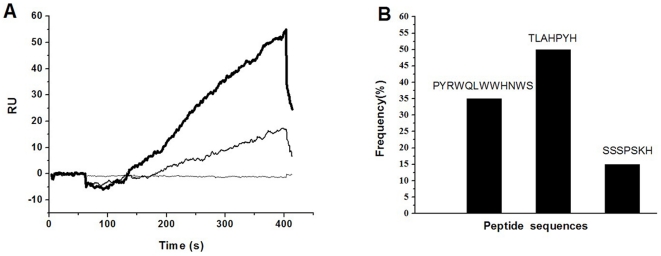
The specific affinity and amino acid sequences of the selected phages.(A) Specific affinity between Aβ1-10 and the phages screened for three rounds. Real dark line: binding specificity test of the screened phages; Dash line: competitive inhibition test of the small peptide; Horizon line: the baseline of reaction unit; (B) Amino acid sequence of peptides displayed by the 20 selected phage clones. Frequency of peptides was displayed by the phage clones. Three sequences were highly represented.